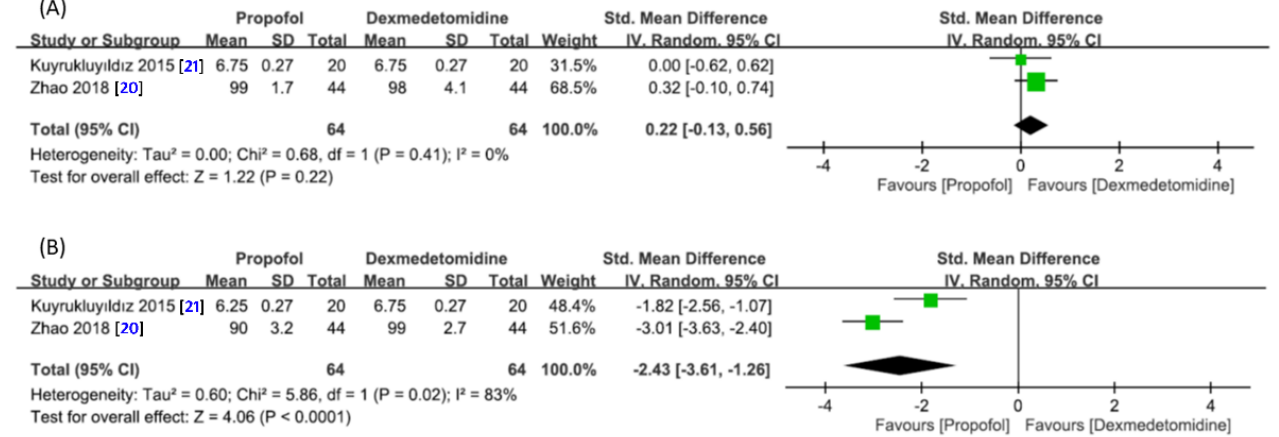
Figure 8. Forest plot for the comparison of satisfaction of ( A ) patients and ( B ) endoscopic performers between propofol and dexmedetomidine groups after drug-induced sedation. CI, confidence interval; IV, inverse variance; Std, standardized.